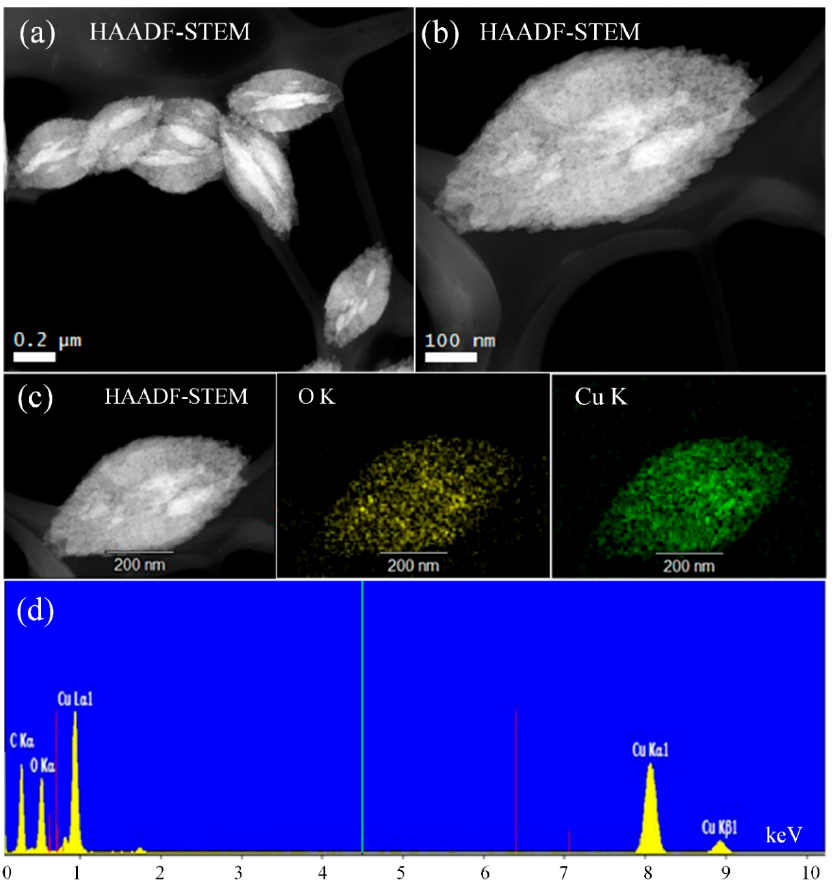
Figure 6. High-angle annular dark-field scanning transmission electron microscopy (HAADF-STEM) analysis. ( a , b ) Low and high magnification HAADF-STEM images of a CuO nanopetal. ( c ) Chemical mapping. ( d ) STEM-EDS pattern of single CuO